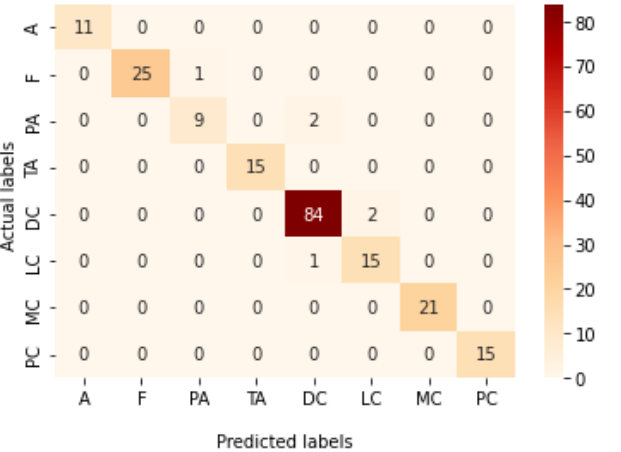
Figure 24. Confusion matrix of Xception model in 40× magnification-dependent multi-classification.